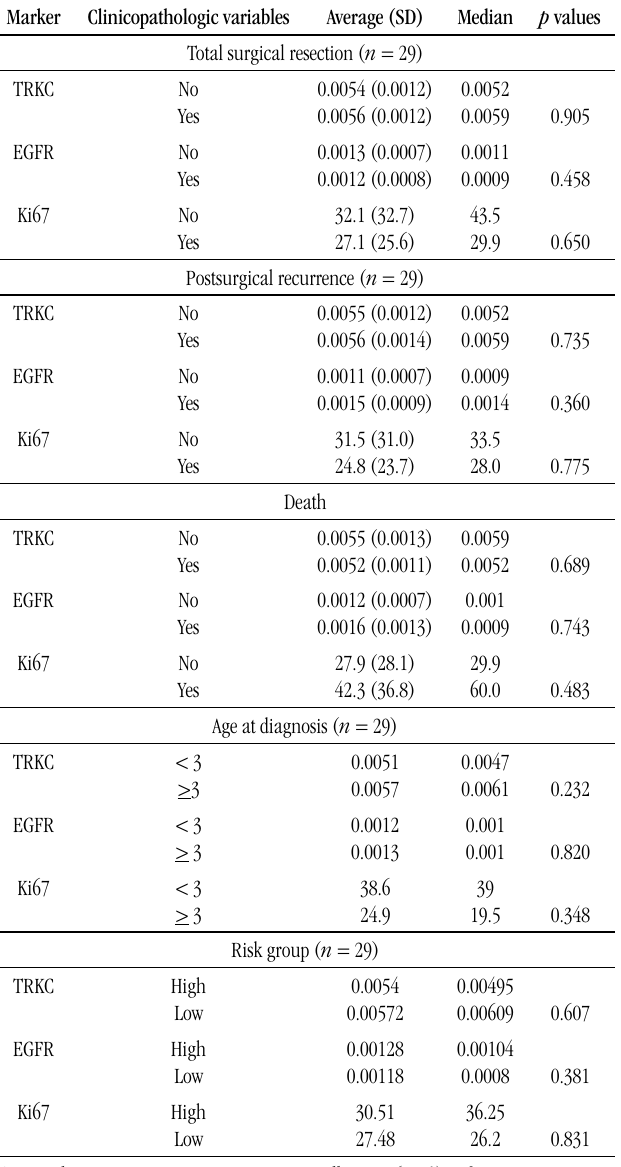
tABLE 2 – Shows the correlation between the average immunoexpression of biomarkers and the clinicopathologic variables of studied patients ( n =